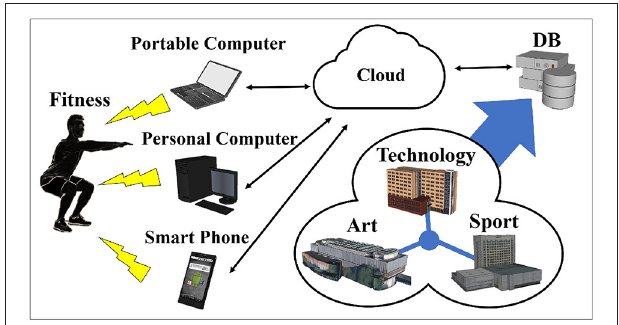
FIGURE 1 | Overview of system